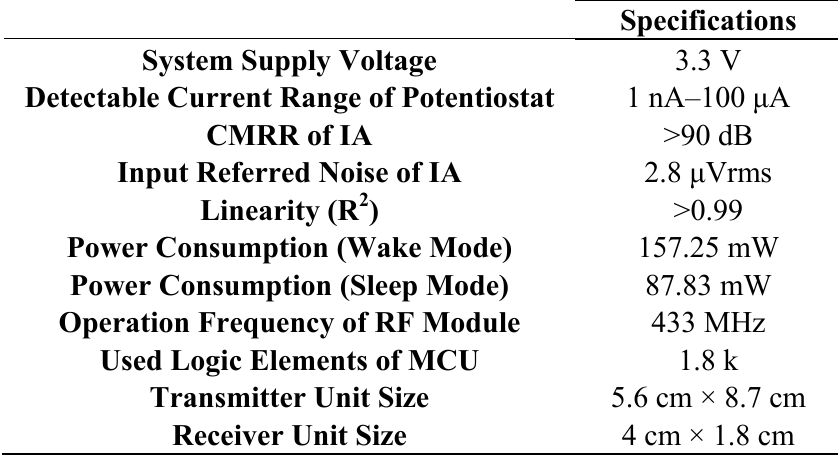
Table 5. Experimental results of the proposed